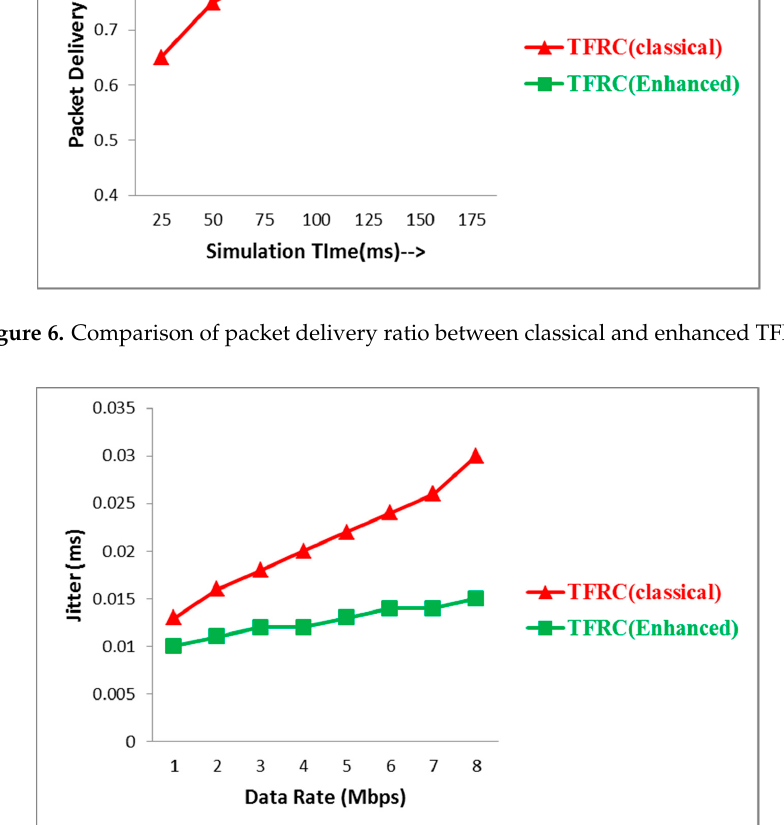
Figure 7. Comparison of jitter between classical TFRC & enhanced TFRC.